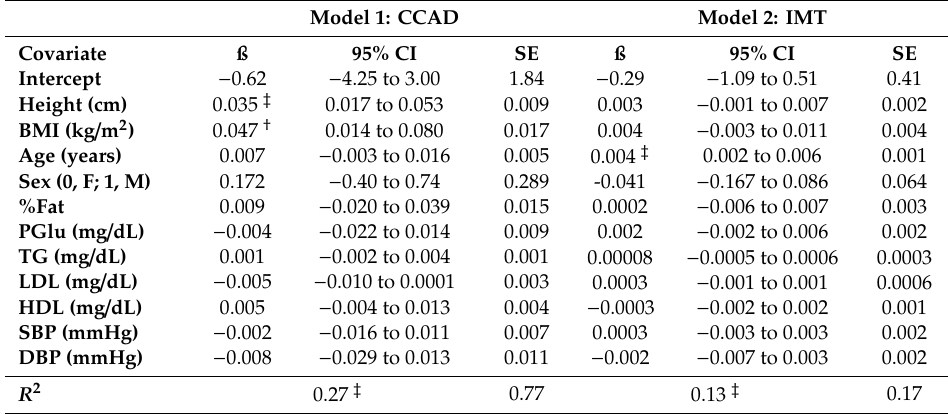
Figure 1. Measured CCAD (mm) and IMT (mm) in men and women versus height (cm). The CCAD correlation is significant at p < 0.001, while the IMT correlation is non-significant ( p = 0.41). Table 2. Right common carotid artery diameter (CCAD) and intima–media thickness (IMT) multiple regression models (n =